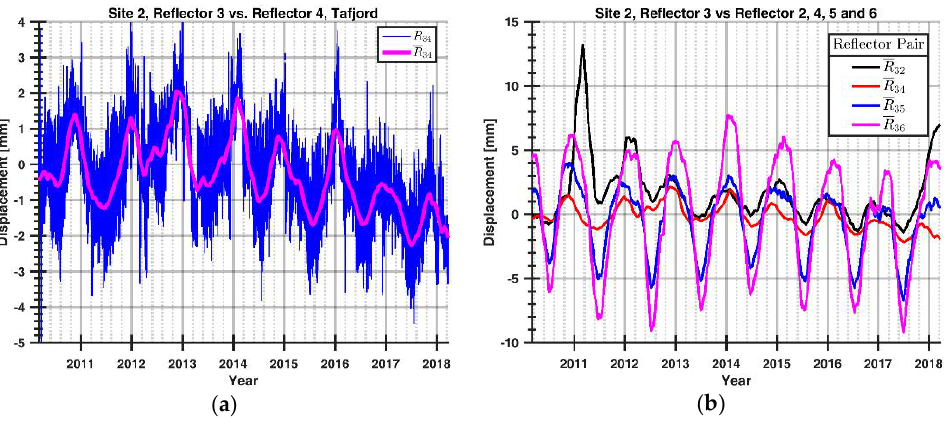
Figure 16. ( a ) The displacement as a function of time for Site 2 from 2010 to 2018, reflector 3 referenced to reflector 4. The blue line is the raw-data, while the magenta line is the 3-months moving mean. The results show a displacement of −1.2 mm for the whole timespan. The displacement from 2013 to 2018 is in the order of −2.0 mm. ( b ) The displacement as a function of time for reflector 3 referenced to the four reference reflectors (reflectors 2, 4, 5, and 6). They all show similar motion, the major difference being the variation in the amplitude of the annual cyclic motion. The standard deviation increases with the distance between reflector 3 and the reference reflectors. Table 5. Measured displacement of reflector 3, referenced to the four reference reflectors.